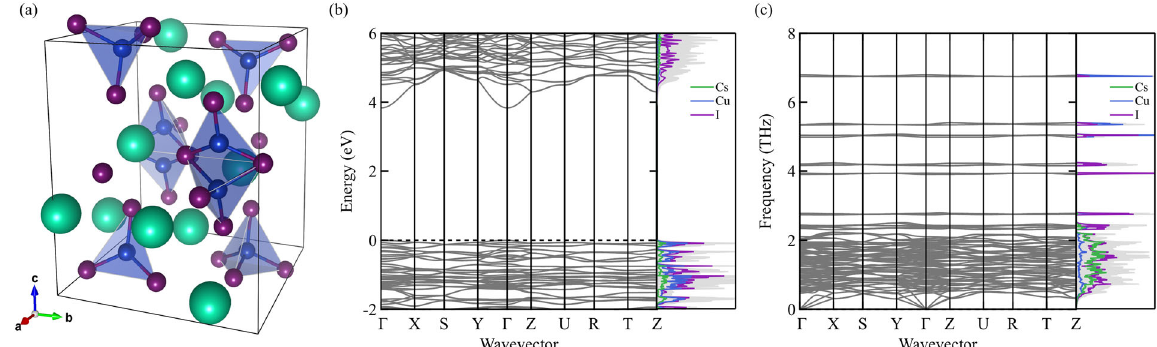
Fig. 1 Crystal and band structures. a Crystal structure, b electronic band structure (the valence band maximum is set to 0 eV), and c phonon band structure of Cs 3 Cu 2 I 5 . Atom projected density of states are plotted on the right side of electronic and phonon band structures, where Cs, Cu, and I contributions are shown in green, blue, and purple lines,